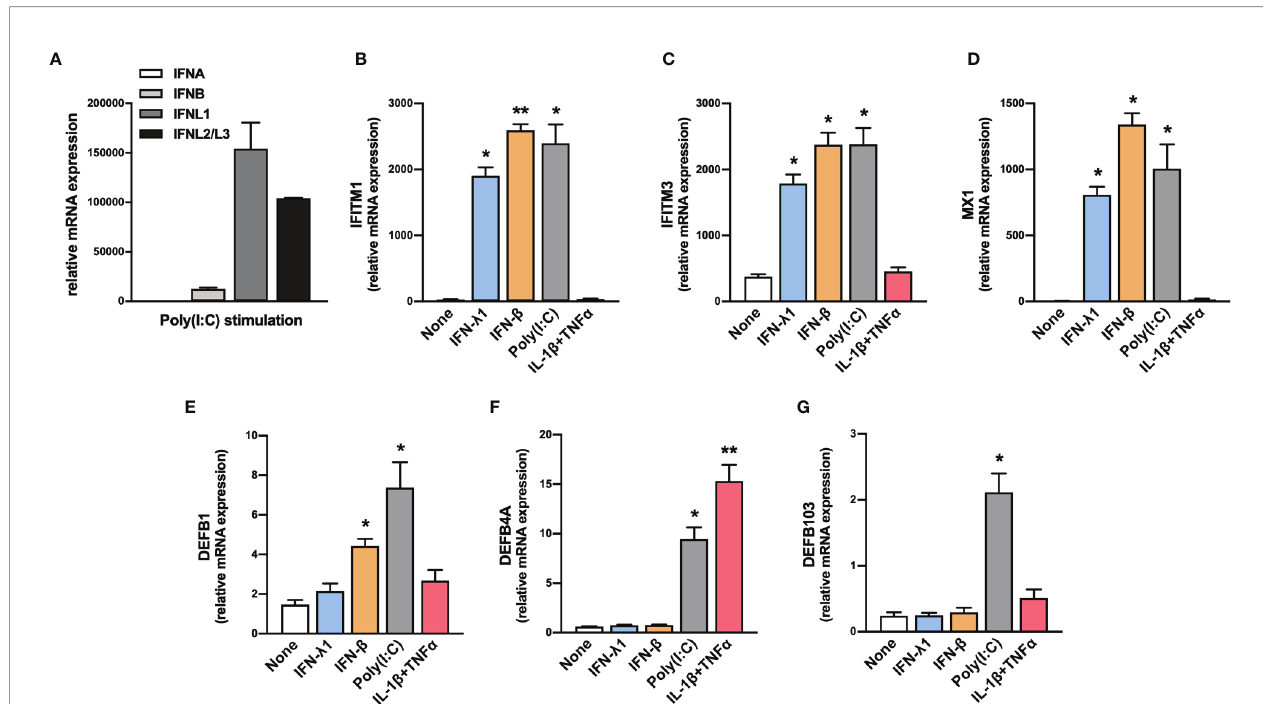
FIGURE 2 | Expression of IFNs, ISGs and b -defensins by HNEpC upon stimulation. (A) The expression of IFNA , IFNB , IFNL1 , and IFNL2/L3 transcripts was determined by RT-qPCR in human nasal epithelial cells (HNEpC) following poly(I:C) stimulation (n=3). (B – G) The expression of IFITM1 , IFITM3 , MX1 , DEFB1 , DEFB4A , and DEFB103 transcripts was determined by RT-qPCR in HNEpC following IFN- b , l ’ IFN- l 1, poly(I:C), or IL-1 b + TNF a stimulation for 24h (n=3). Mean ± SEM. Data are compared using one-way ANOVA test followed by Dunnett ’ s multiple comparisons test (B – G) . *p < 0.05, **p <